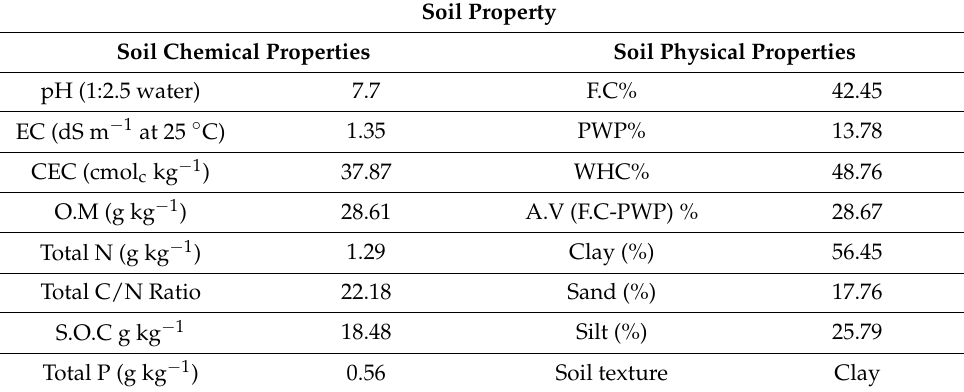
Table 3. Estimated soil physicochemical